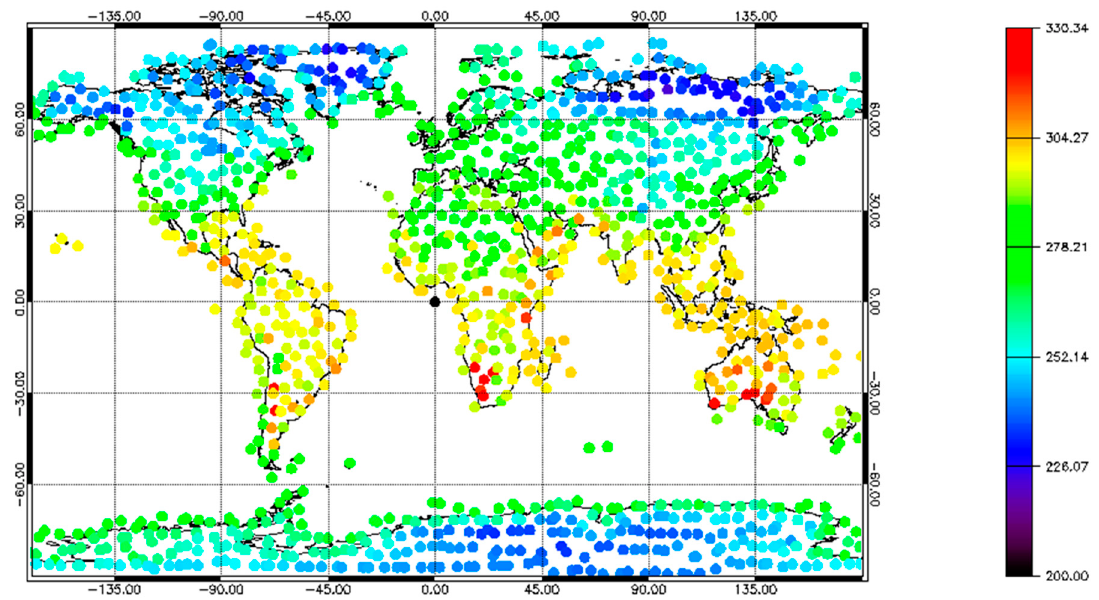
Figure 1. Skin Temperature (K) from ERA5 re-analysis for 5 January 2015. Points that appear to be in the middle of the ocean are profiles over islands not represented in the map outline used.